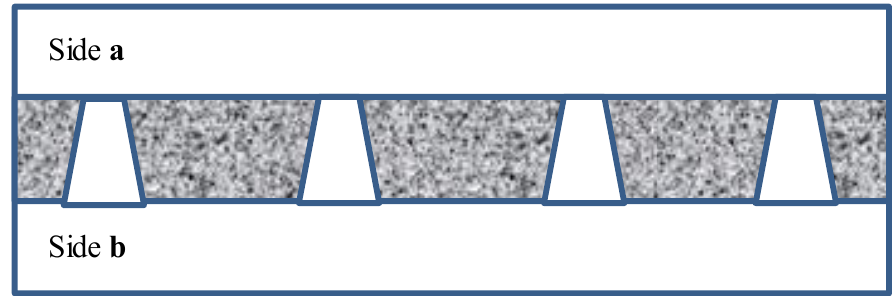
Figure 2. Schematic representation of the cross-section of asymmetric membranes.